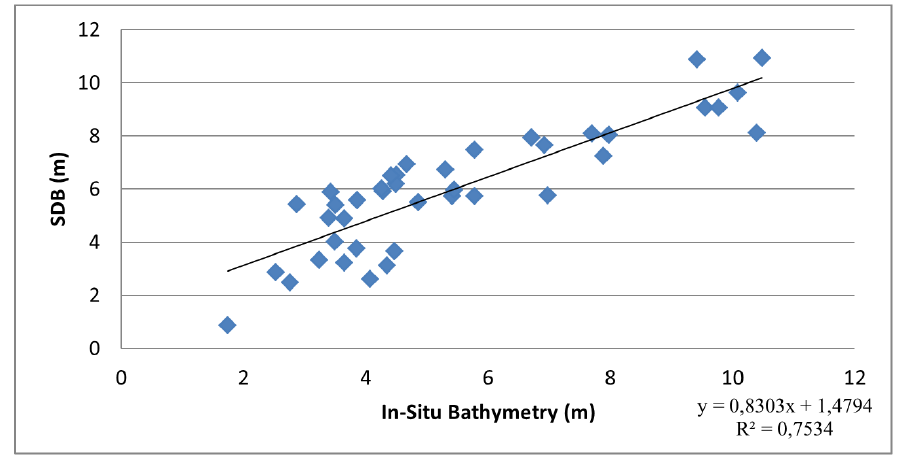
Figure 12. The relationship between SDB, obtained using log-band ratio method, and in-situ bathymetry acquired on the coast of San Vito Lo Capo. Table 6. Quality assessment of satellite-derived bathymetry